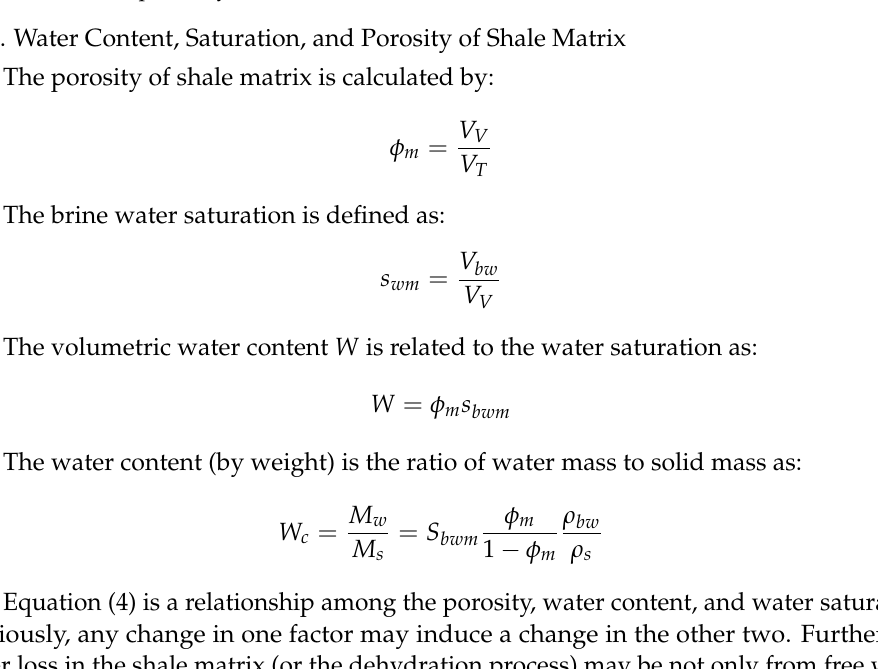
Figure 3. CO 2 -water displacement in tight caprock. The abbreviated letters P wm , P wf , P CO 2 and CO 2 P are short for the pressures of water in the matrix, water in the fractures, CO 2 in the matrix, and CO 2 in the fractures, respectively.